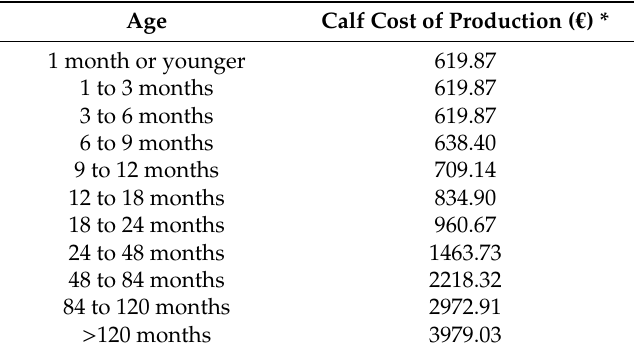
Table 3. Production cost of animals for reproduction by